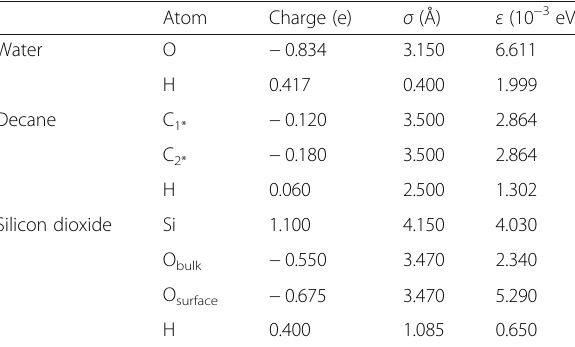
Table 1 Non-bonded potential parameters used in the simulation